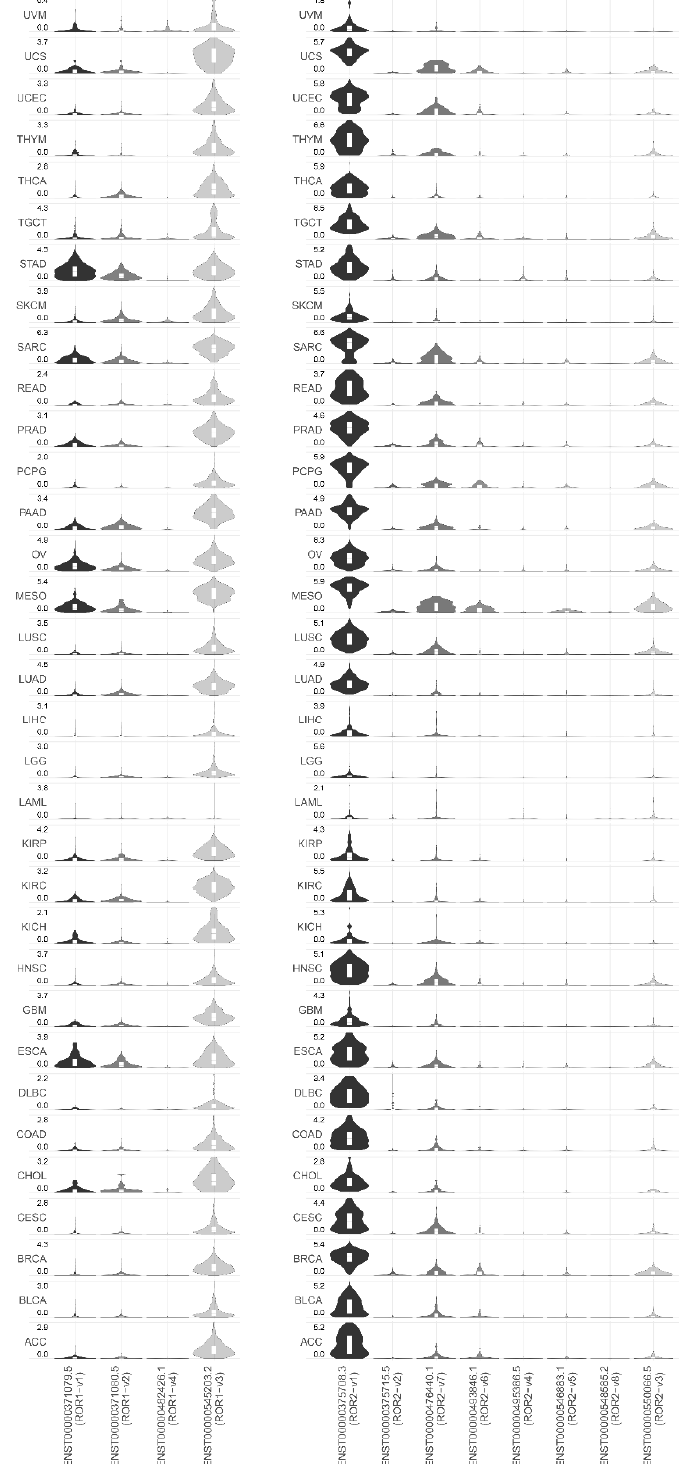
Figure 4. Analysis of ROR1 and ROR2 transcript variant expression in human tumour tissues: ( A ) Expression of transcript variants of ROR1 in 33 tumour types examined by TCGA. ( B ) Expression of transcript variants of ROR2 in 33 tumour types examined by